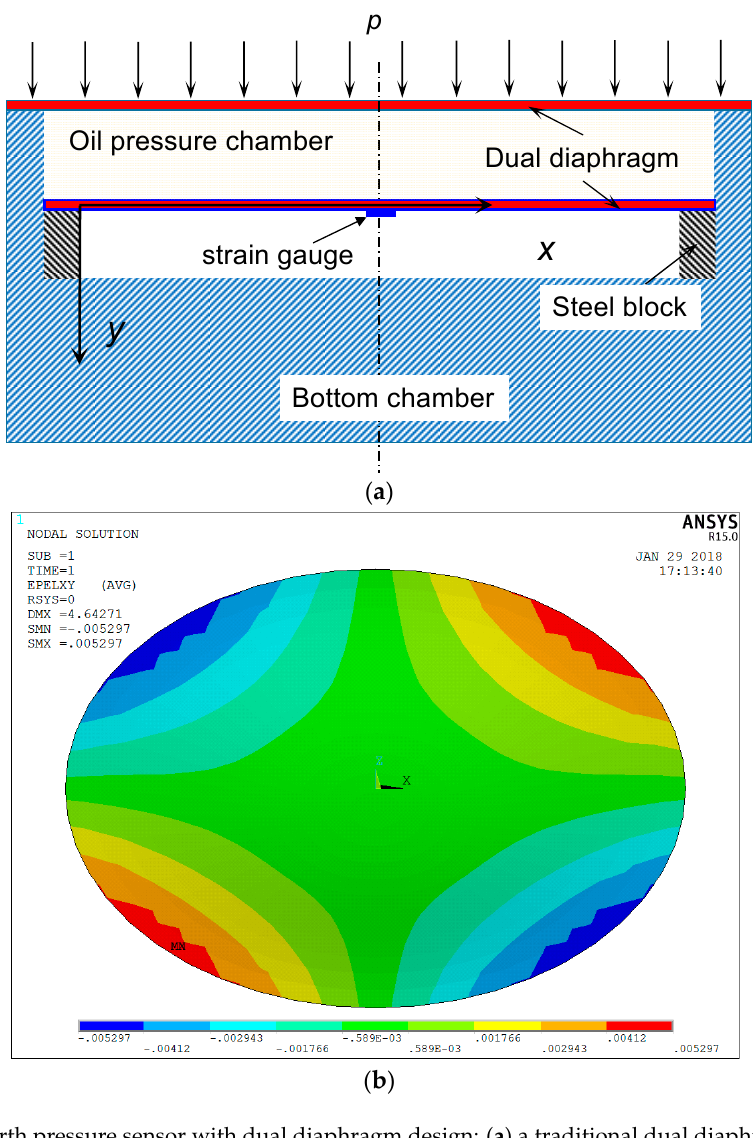
Figure 2. Earth pressure sensor with dual diaphragm design: ( a ) a traditional dual diaphragm design; ( b ) finite element analysis results of xy-shear strains of the diaphragm under normal pressure of 200 kPa.